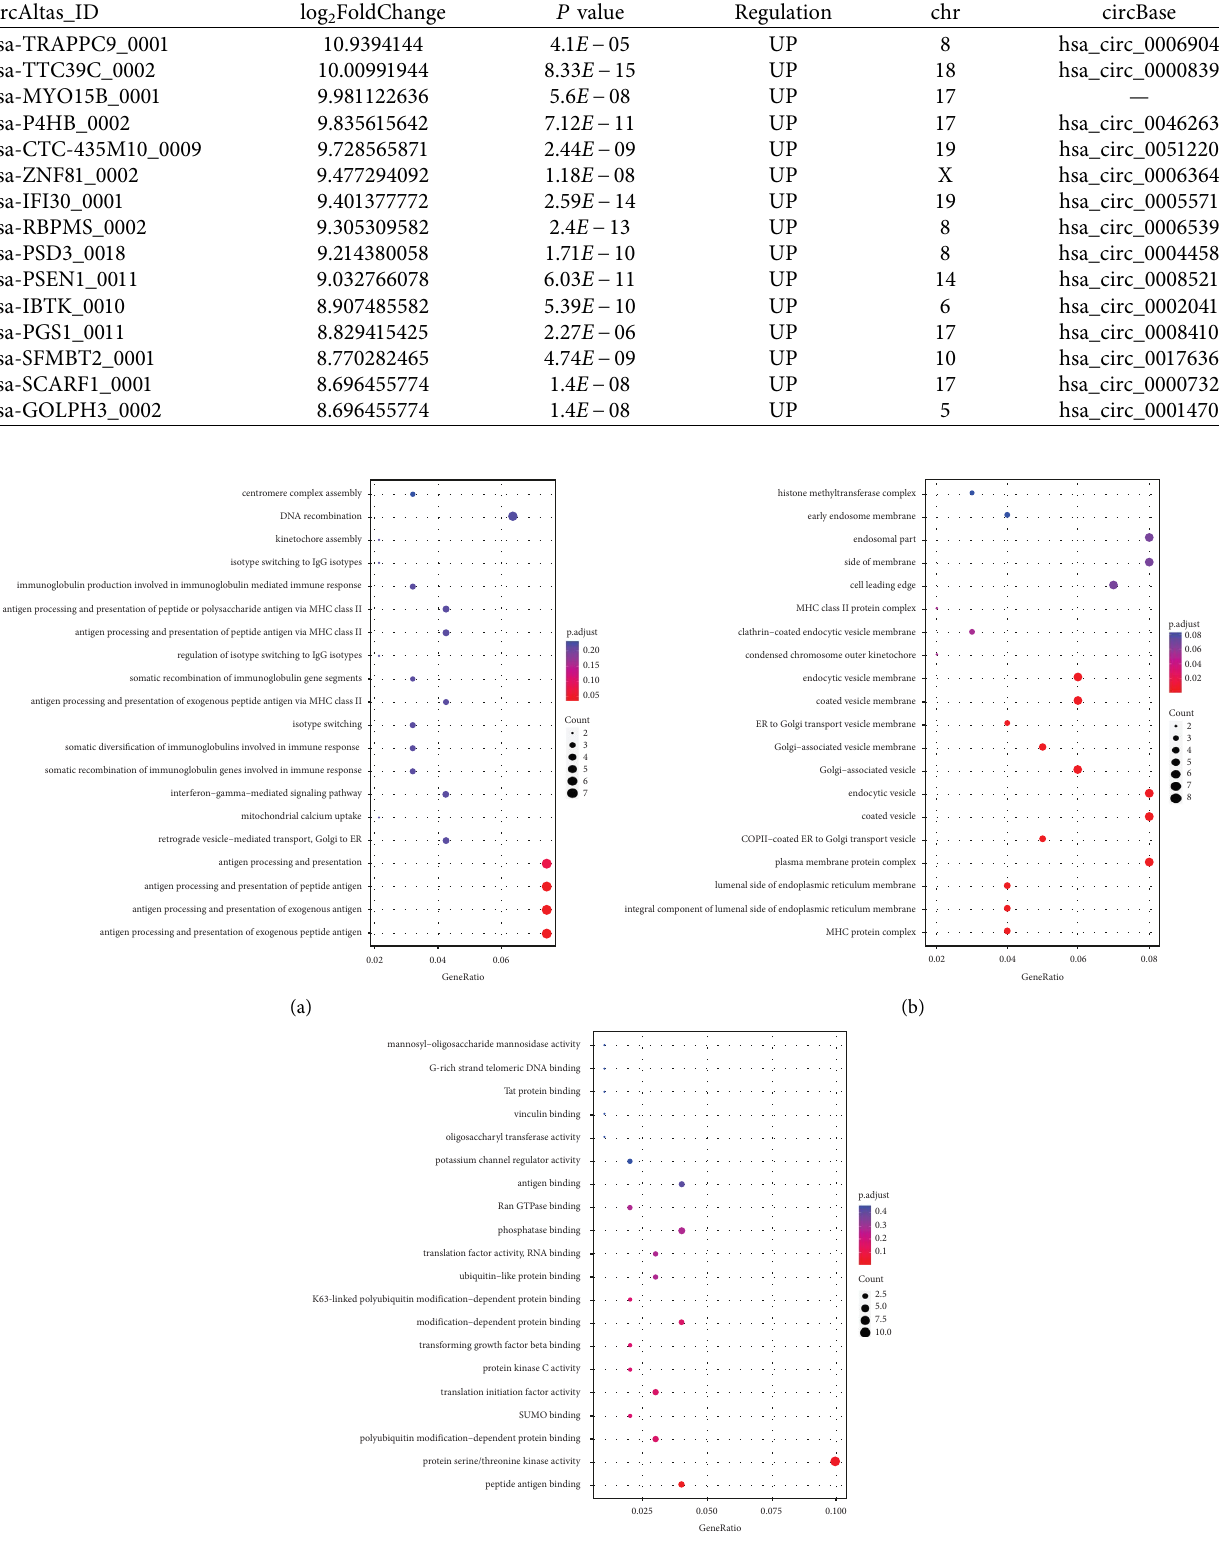
Table 3: Top 15 upregulated circRNAs in unstable